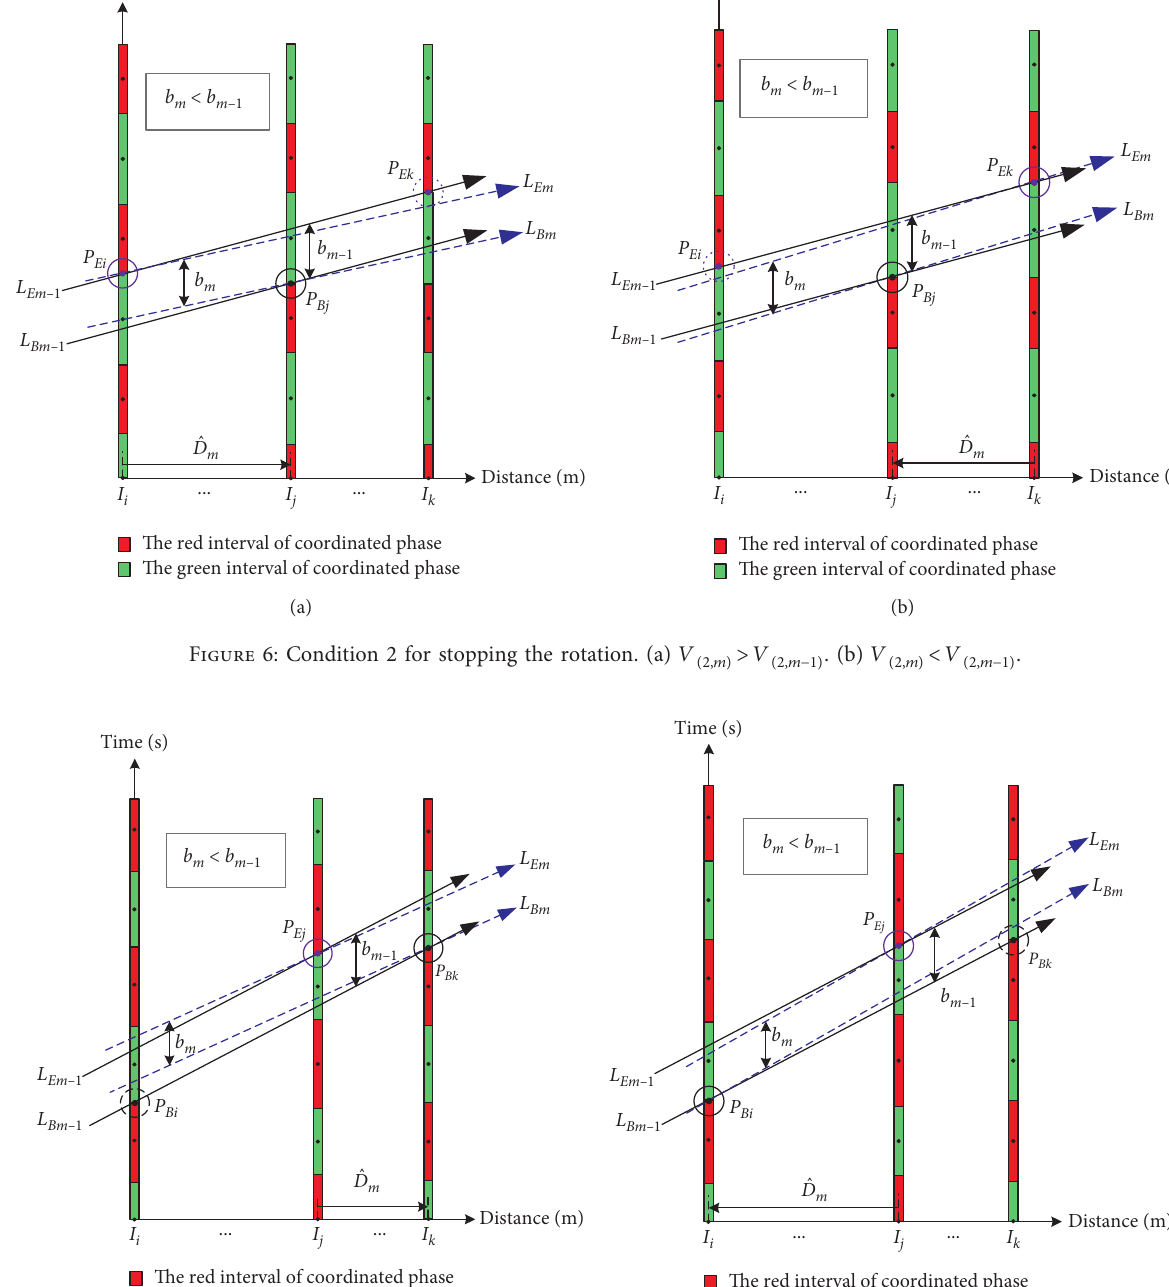
V V V ( 2 ,m ) > ( 2 ,m − 1 ) . (b) ( 2 ,m ) < ( 2 ,m − 1 )